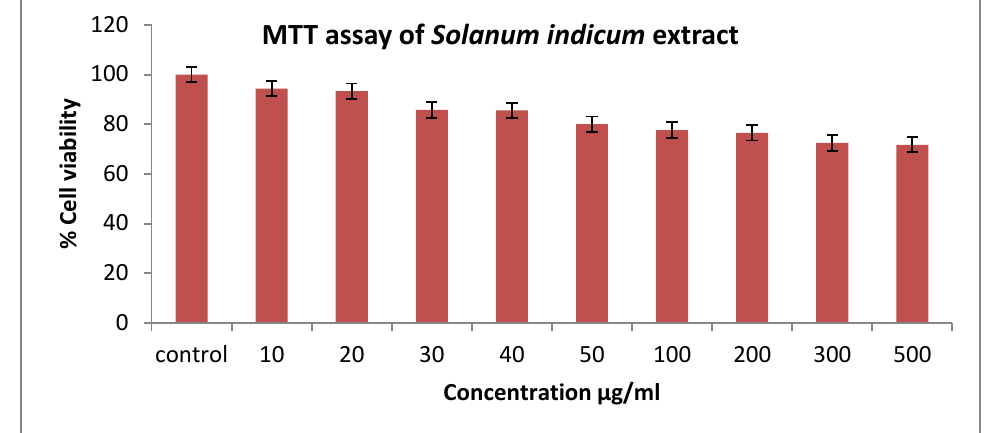
Figure 2. MTT assay of Solanum indicum extract.